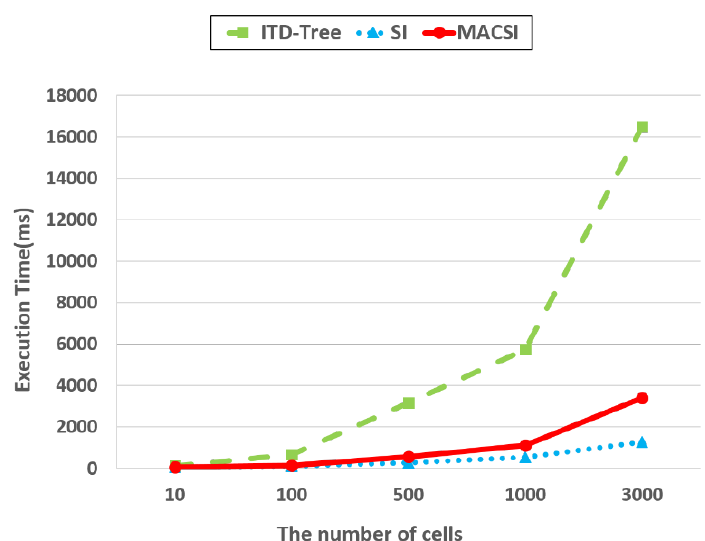
Figure 20. The effect of cell number on the coarse-grained semantic cell query performance.